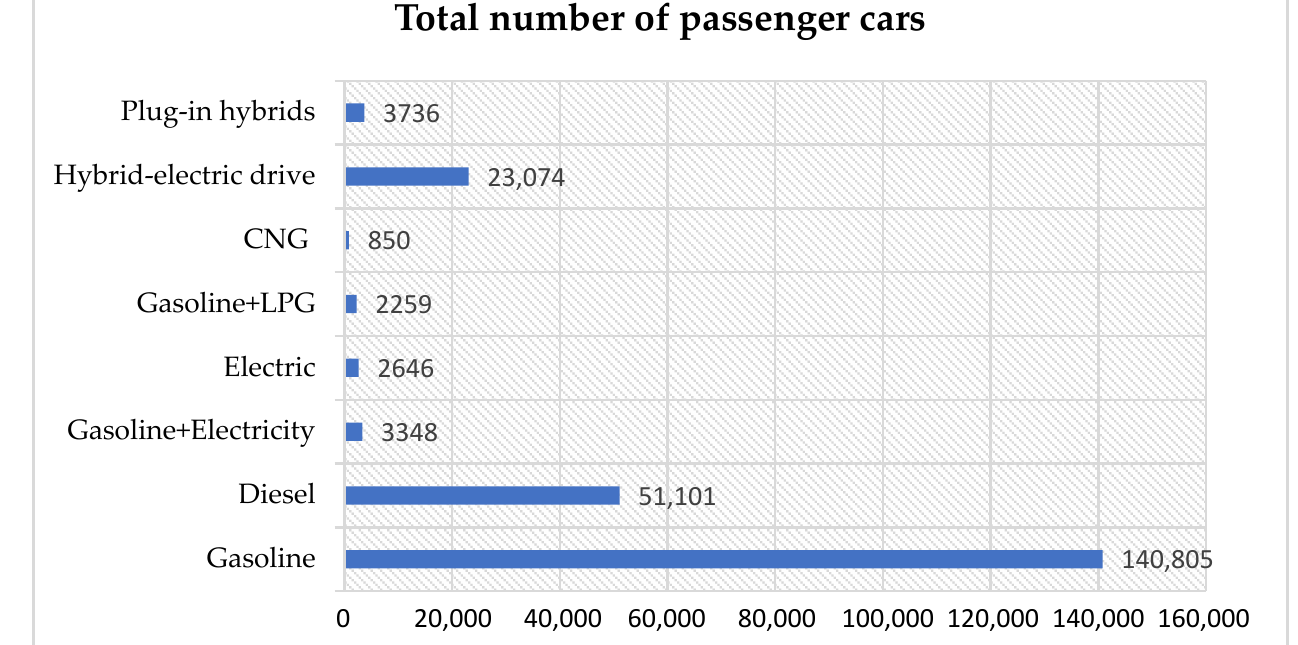
Figure 1. Total number of passenger cars in the Czech Republic in 2021.